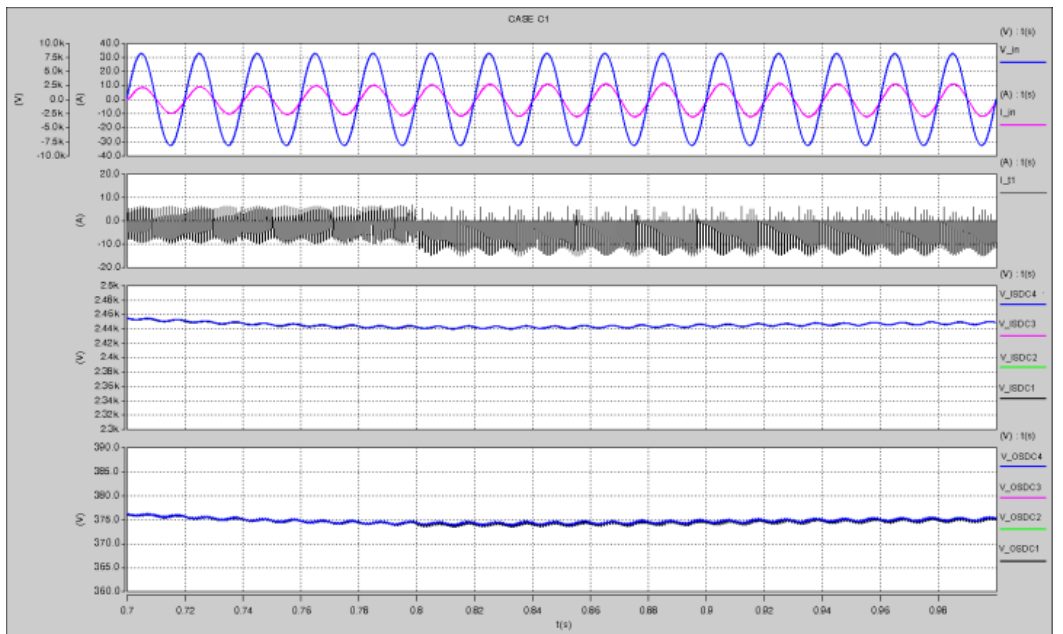
Figure 15. Simulat0ion results of fault C1.